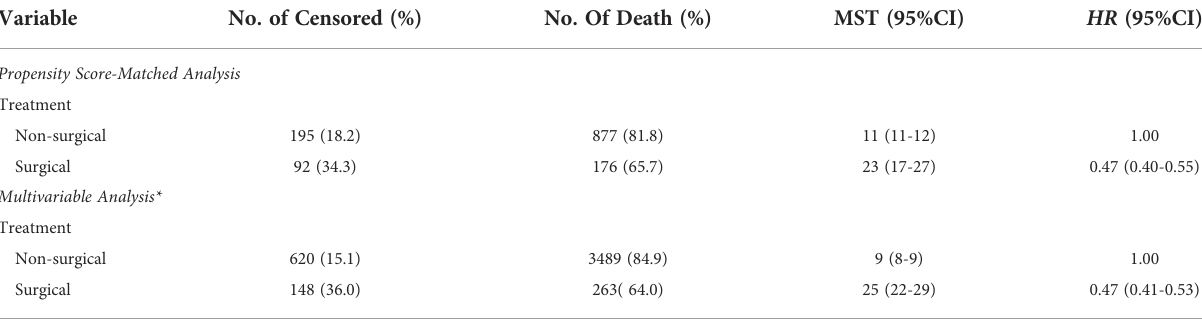
TABLE 2 The role of different treatments on overall survival of patients with metastatic esophageal adenocarcinoma. Variable